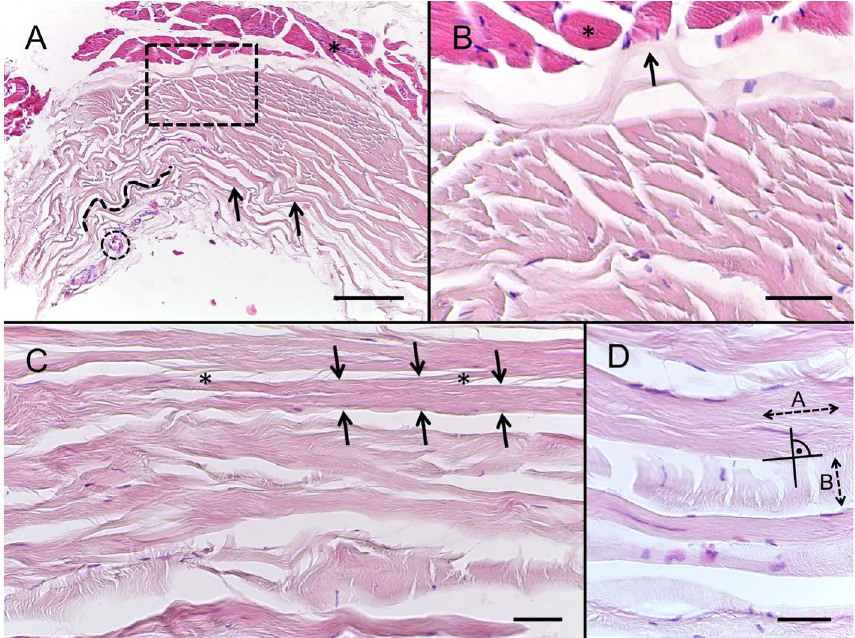
Figure 8. Haematoxylin & eosin images of the temporal muscle fascia (TMF). ( A ) A horizontal section of the TMF is depicted covering the temporal muscle (asterisk). TMF consists of collagen bundles (black arrows) organized in several layers. In several parts, a crimping pattern of the collagen bundles was observed (dotted line). A frontal branch of a superficial temporal vessel is shown (dotted circle). Magnification: 100 × , scale bar: 100 μm. ( B ) The image corresponds to the box shown in A and displays the transition between the TMF and the temporal muscle (asterisk). The TMF is attached to the temporal muscle with its innermost collagen layers. This discontinuous attachment had to be cut sharply when the TMF was removed from the muscle for biomechanical tests conducted in this study. Magnification: 200 × , scale bar: 50 μm. ( C ) At a higher magnification it could be observed that the collagen bundles (black arrows indicate a collagen bundle) were sparsely interconnected (asterisks) among each other over longer distances. Magnification: 200 × , scale bar: 50 μm. ( D ) The predominant collagen bundles (dotted arrow marked with A ) were connected by a perpendicular running thin collagenous layer (reflected by the dotted arrow marked with B ). Magnification: 400 × , scale bar: 50